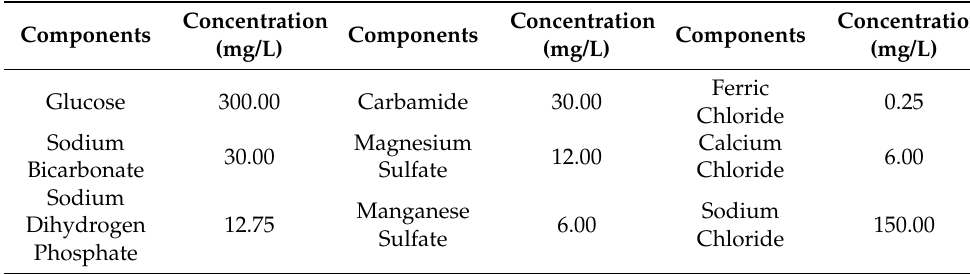
Table 1. The composition of feed